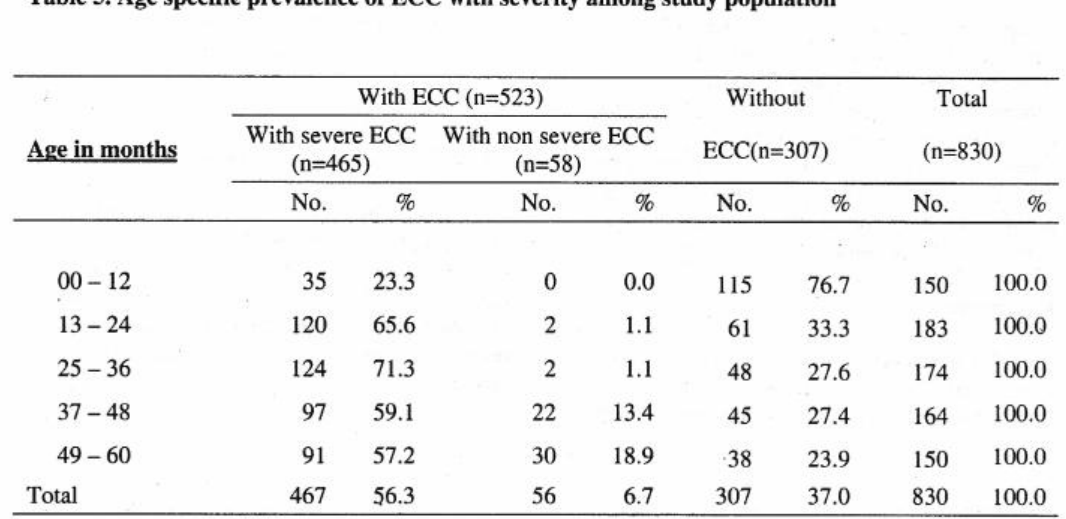
Table 5. Agespecific prevalence of ECC with severity among study